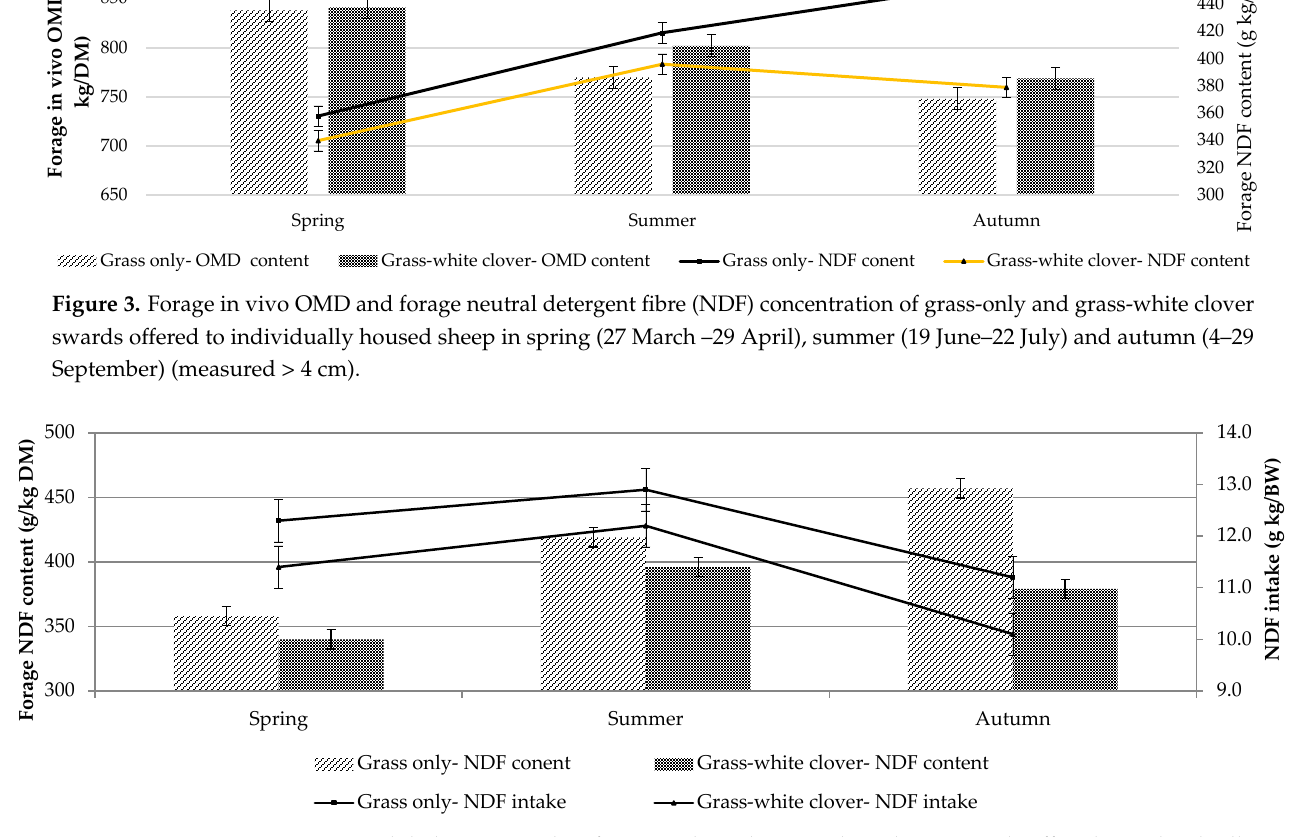
Figure 4. Forage NDF content and daily NDF intake of grass-only and grass-white clover swards offered to individually housed sheep in spring (27 March – 29 April), summer (19 June – 22 July) and autumn (4 – 29 September) (measured > 4 cm). Table 4. Effect of season (spring (27 March – 29 April), summer (19 June – 22 July) and autumn (4 – 29 September)) and forage type offered (grass-only or grass-clover) to individually housed sheep on the digestibility of nutrient components.